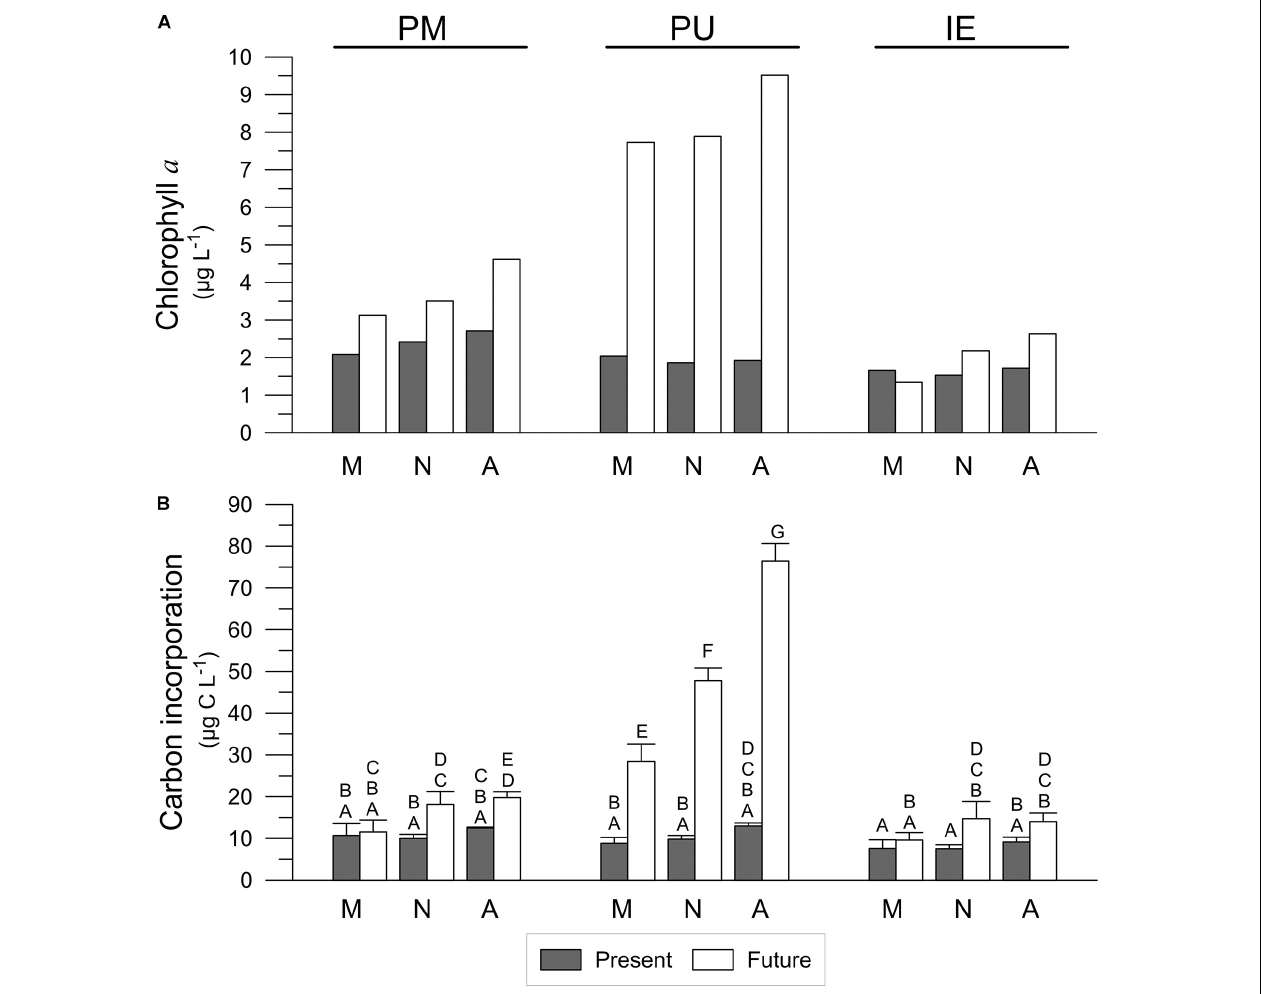
FIGURE 4 | Chlorophyll a concentration (A) and carbon incorporation (B) of the samples collected in Puerto Madryn (PM), Playa Unión (PU) and Isla Escondida (IE) after being acclimated for 2 days under the Present (Pre) and Future (Fut) scenarios. Capital letters indicate the post-hoc results for the interaction time × site × scenario (2-way RM-ANOVA). M, N and A letters indicate morning, noon and afternoon, respectively. Lines on the top of the bars indicate standard